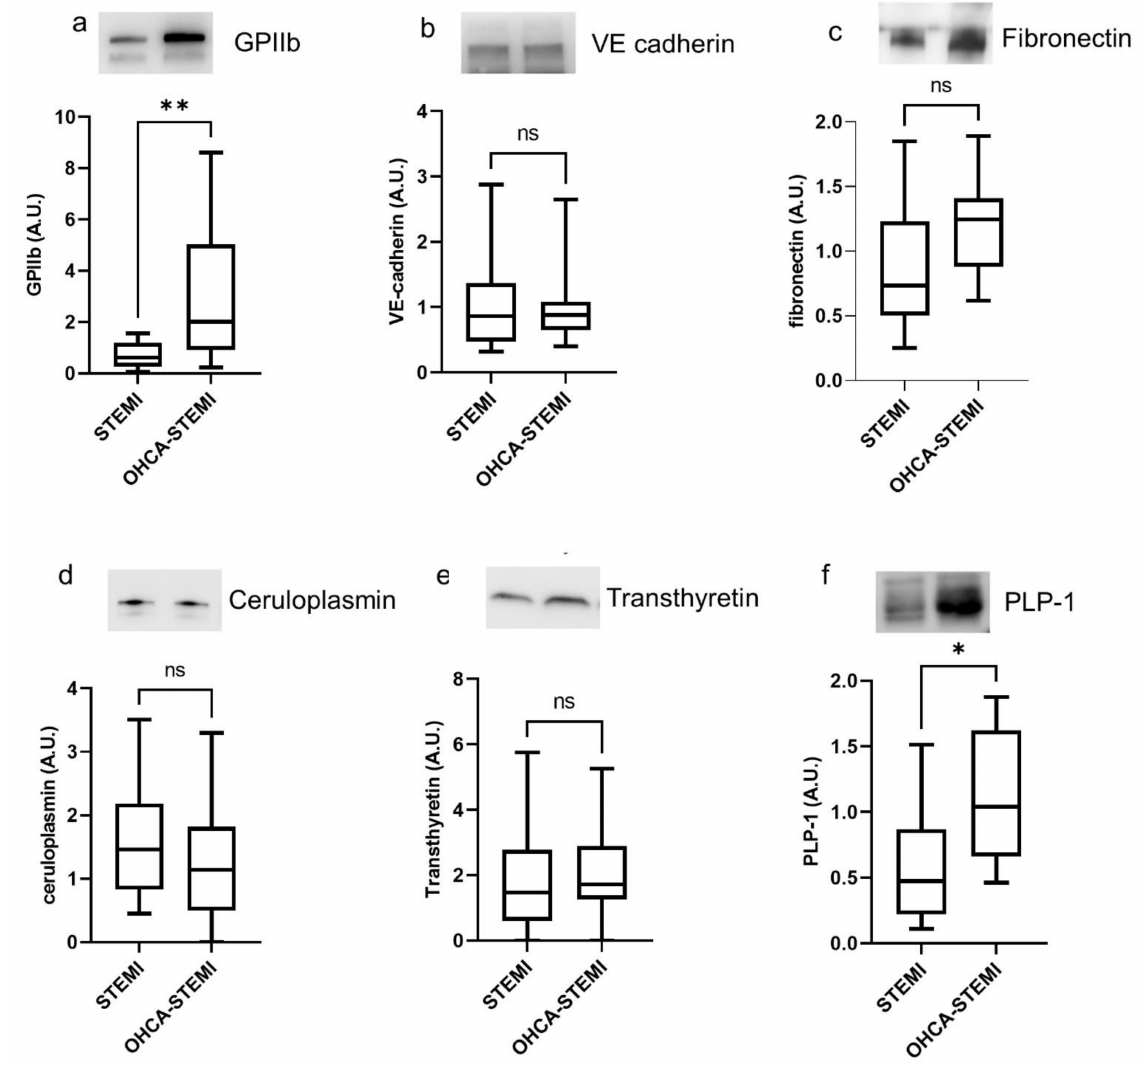
Figure 4. Plasma exosomes of OHCA-STEMI patients display a greater expression of platelet and brain-associated markers. ( a – f ) Densitometric quantification and representative images of Western blot analysis of GPIIb ( a ), VE-cadherin ( b ), fibronectin ( c ), ceruloplasmin ( d ), transthyretin ( e ) and PLP1 ( f ). For each box plot, the center line illustrates the median and box limits indicate the 25th and 75th percentiles. ns: not significant, * p < 0.05, ** p <